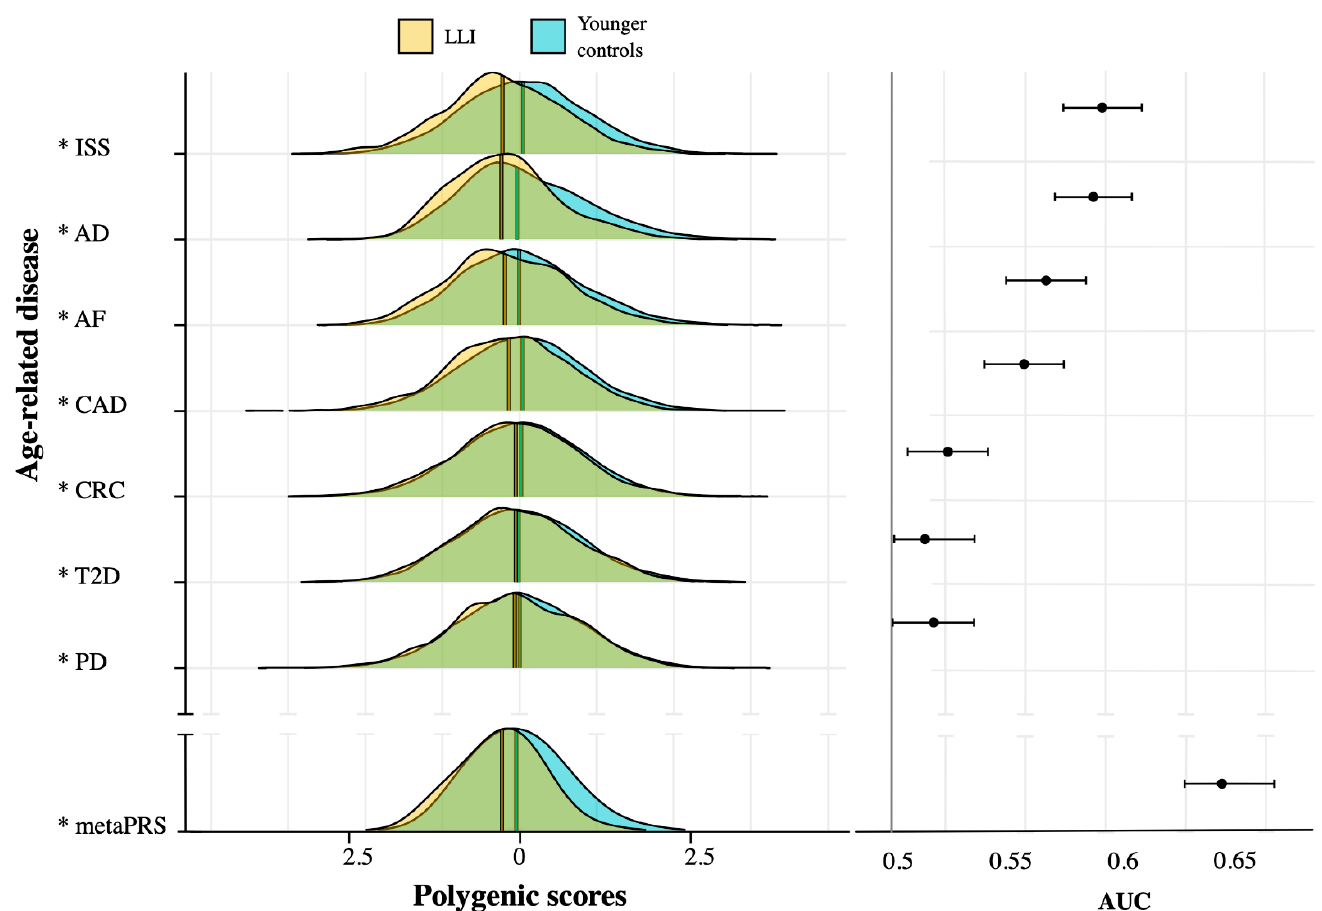
Figure 1. Scaled distribution of the polygenic risk scores of the single age-related diseases (ARD-PRSs) in long-lived individuals (LLI) and younger controls (Ctrl) and areas under the curve (AUCs) with 95% confidence intervals. Depicted values were taken from the model in which only the contributions of the PRSs were taken into account. Asterisks (*) indicate a significant relationship between the PRSs and longevity based on the logistic regression model. ISS, ischemic stroke; AD, Alzheimer’s disease; AF, atrial fibrillation; CAD, coronary artery disease; CRC, colorectal cancer; T2D, type 2 diabetes mellitus; PD, Parkinson’s disease; metaPRS, polygenic score calculated using the single ARD-PRS as influence variable. Within each distribution, the vertical line represents the mean. The black horizontal lines on the right represent the interquartile range and the circles represent the median AUC for each PRS. Table 1. Accuracy statistics for the calculation of each ARD-PRS in the German study population.